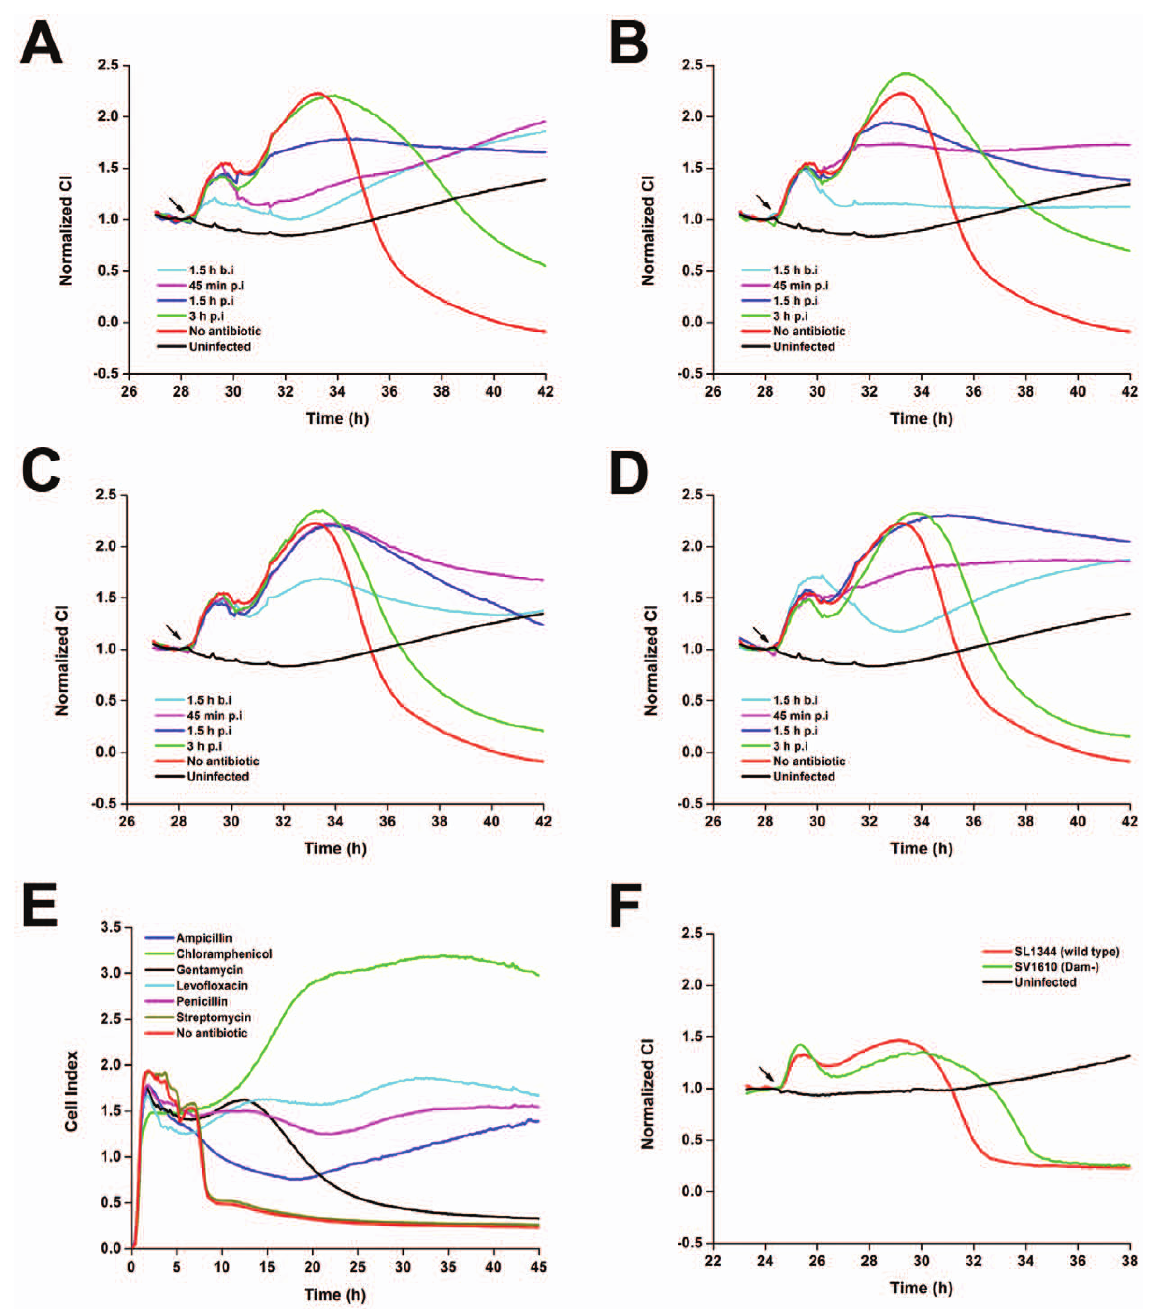
Figure 4. Broad application of cell-based infection model. (A–D) Dynamic monitoring of HT-29 cells during S. typhimurium infection after antibiotic addition at different time points. Kanamycin (A), ampicillin (B), chloromycetin (C) and levofloxacin (D). b.i, before infection; p.i, post- infection. (E) Intracellular activities of antibiotics against Salmonella . S. typhimurium strain SL1344 was phagocytosed by J774A.1 cells and extracellularly exposed to antibiotics at 10 6 MIC. (F) S. typhimurium Dam deficiency results in extended host cell survival. HT-29 cells were infected with S. typhimurium wild type stain SL1344 or Dam deficient stain SV1610 at MOI=200. Arrows, bacterial addition. Representative curves are an average of four replicate